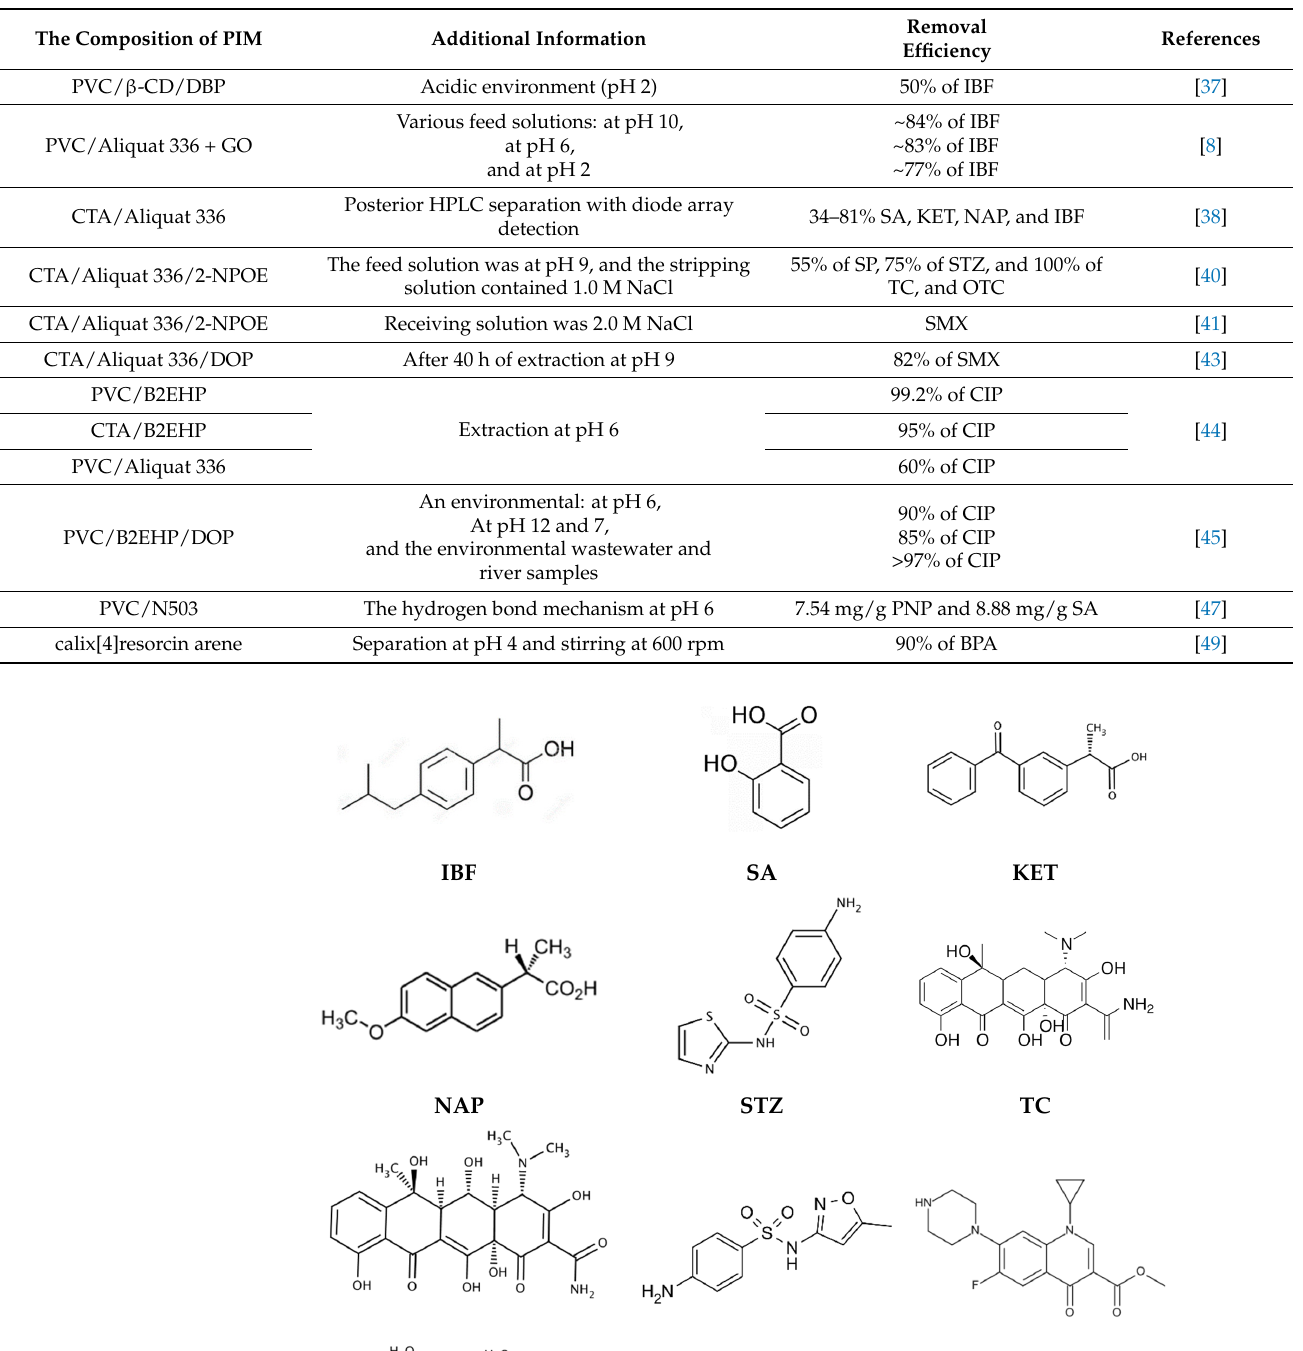
Table 1. Examples of removal of pharmaceuticals and endocrine-disrupting compounds by methods based on utilization of PIMs.